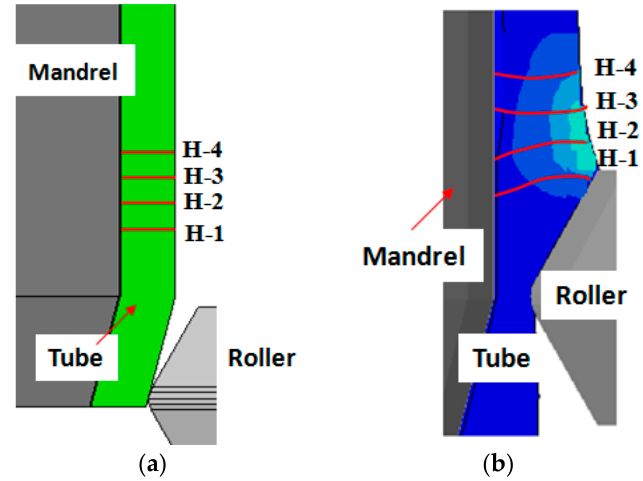
Figure 12. ( a ) Paths in tube blank and ( b ) paths in spun tube.